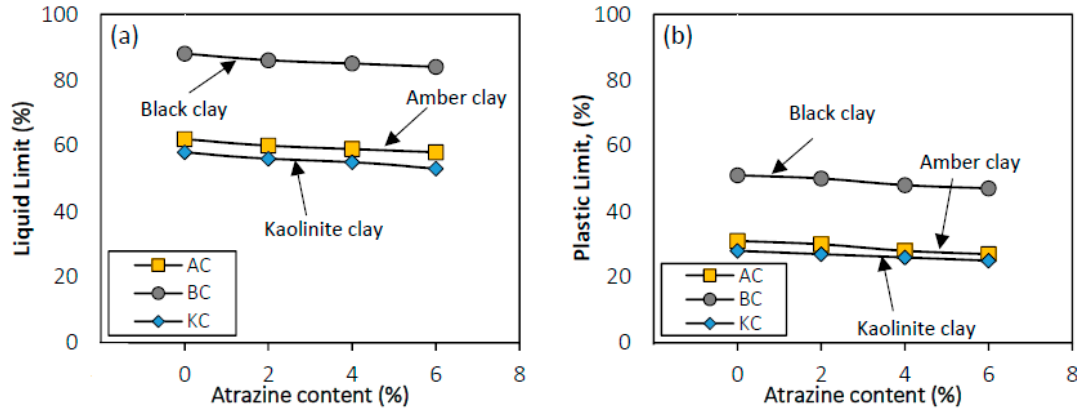
Figure 6. Atterberg limit test results for Amber Clay (AC), Black Clay (BC), and Kaolinite Clay (KC) specimens contaminated at different Atrazine contents (a) Liquid Limit (LL) versus Atrazine content; (b) Plastic Limit (PL) versus Atrazine content.